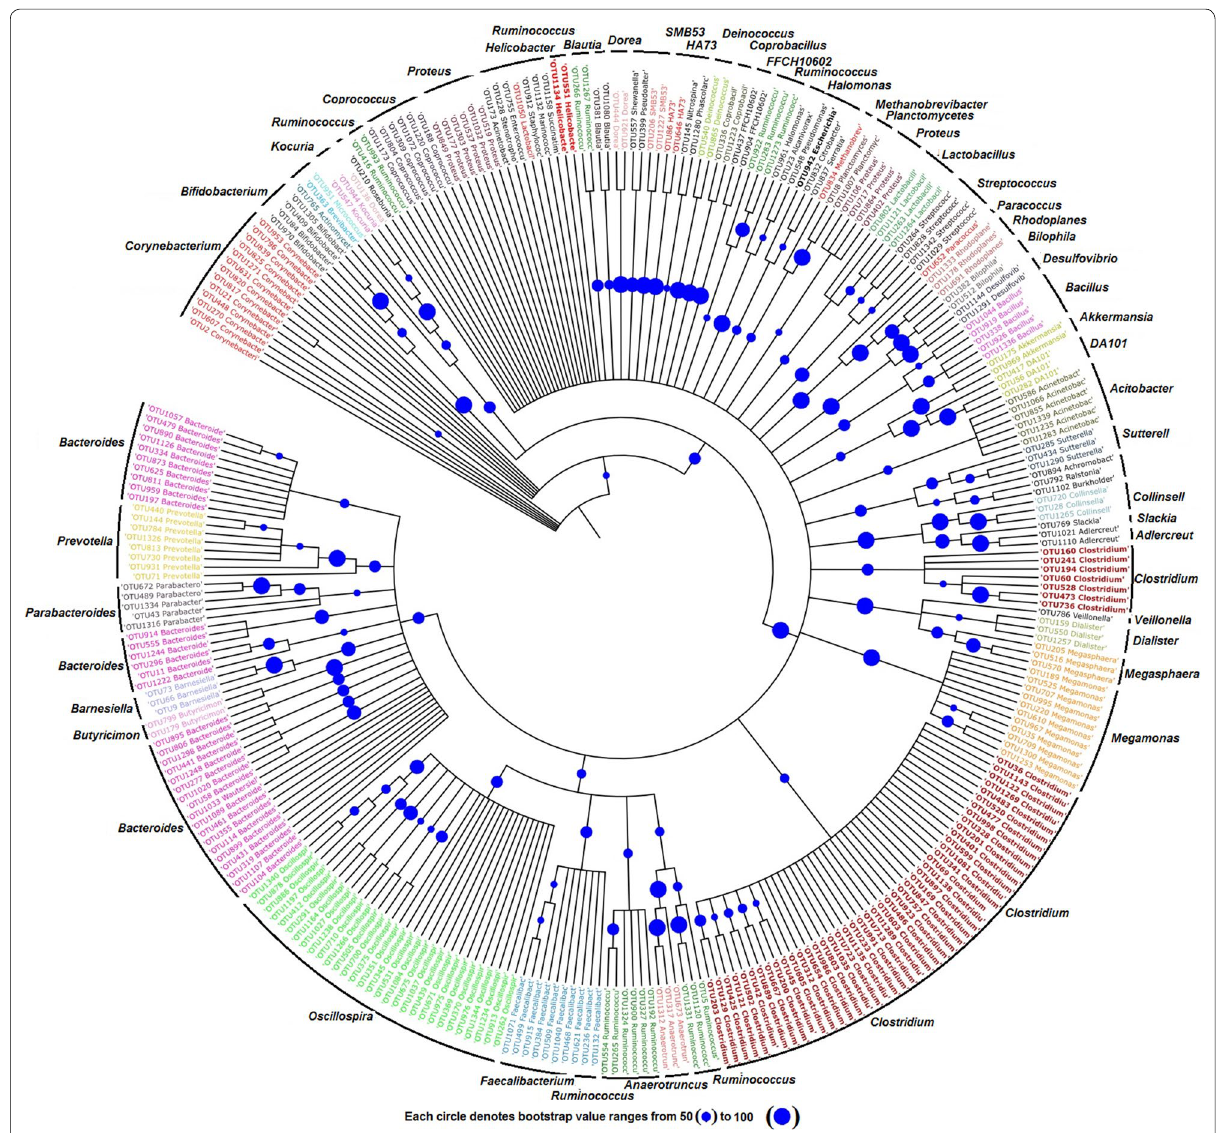
Fig. 5 Phylogenetic tree based on the identified genera using neighbour joining